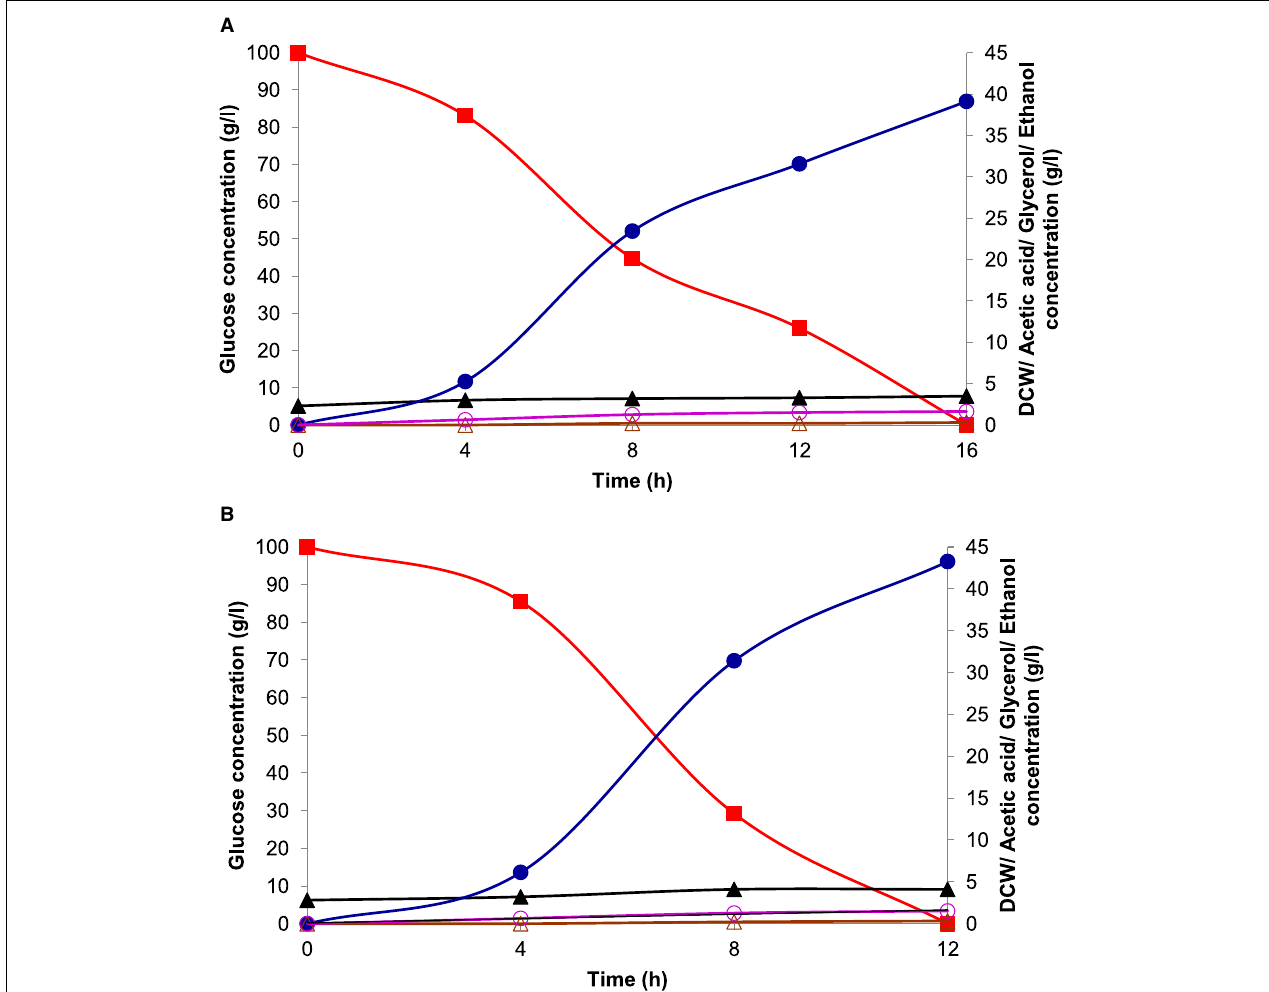
FIGURE 9 | Fermentation profile of (A) K. marxianus NIRE-K1 and (B) K. marxianus NIRE-K3 in bench-scale bioreactor at optimized growth conditions, ( (cid:4) ) Glucose; ( N ) Dry cell weight; ( • ) Ethanol; ( (cid:13) ) Glycerol; ( △ ) Acetic acid.